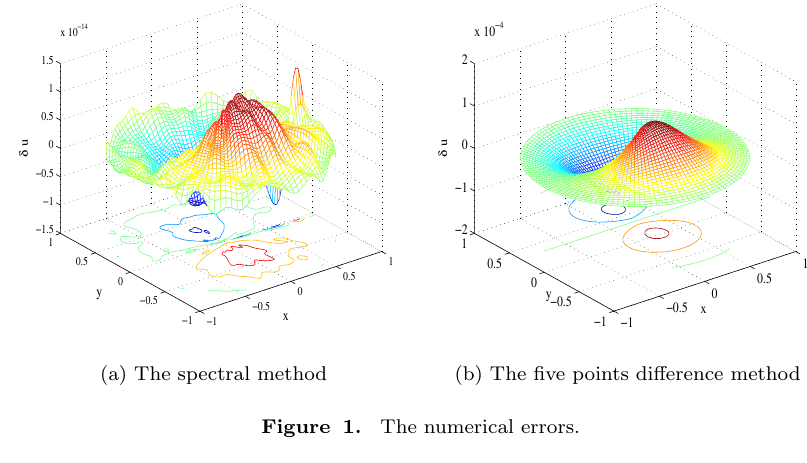
Figure 1. The numerical